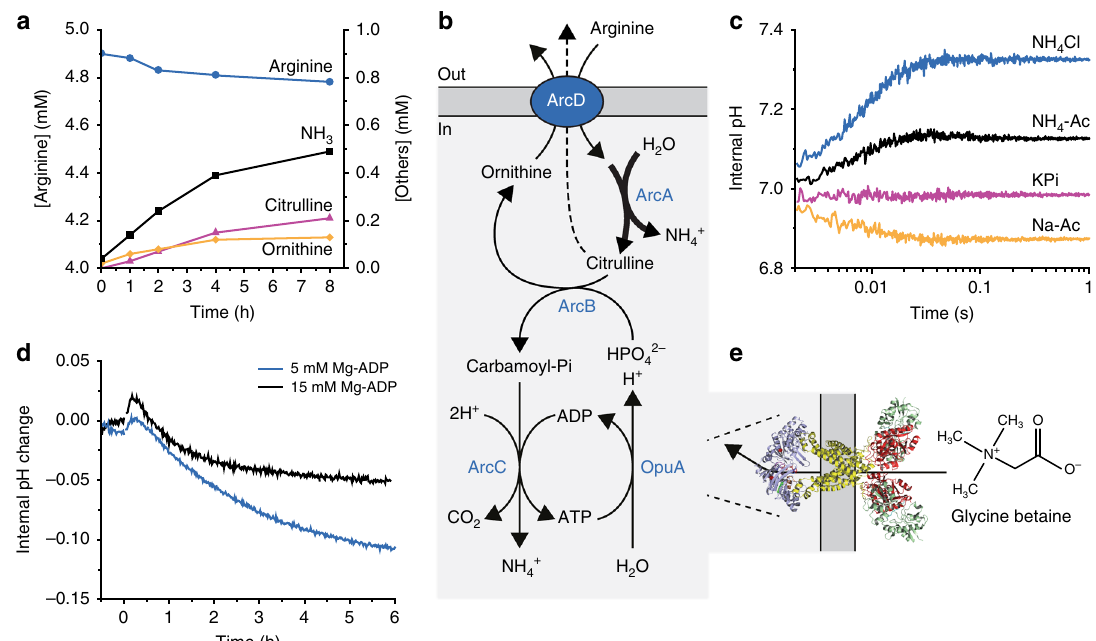
Fig. 4 Control of futile hydrolysis of arginine and pH homeostasis. The internal composition of the vesicles at the start of the experiment is given in Fig. 2a (enzymes) and Table 2 (ions, metabolites) and the preparation of vesicles is given in protocol A1, unless speci fi ed otherwise. a External concentration of metabolites (protocol B6): arginine (blue circles), citrulline (pink triangles), ornithine (yellow diamonds), and NH 3 (black squares), as measured by HPLC in vesicles treated with 25 µ M pCMBS. Five millimolar arginine was added at t = 0. b Schematic representation of arginine breakdown; the futile hydrolysis of arginine and arginine/citrulline exchange are depicted by bold and dashed arrows, respectively. c Stopped- fl ow fl uorescence measurements to determine the permeability of the vesicles for NH 4 Cl (blue trace), NH 4 -acetate (black trace), potassium phosphate (pink trace) and sodium acetate (yellow trace); pyranine inside the vesicles was used as pH indicator ( n ≥ 2). d Internal pH change (protocol B4) of arginine-metabolizing vesicles with either 5 mM Mg- ADP (protocol A1; blue trace) or 15 mM Mg-ADP on the inside (protocol A3; black trace). Five millimolar arginine was added at t = 0 ( n = 2). e Homology model of OpuA and structure of the compatible solute glycine betaine. Glycine betaine import via OpuA consumes the ATP as indicated in ( b )